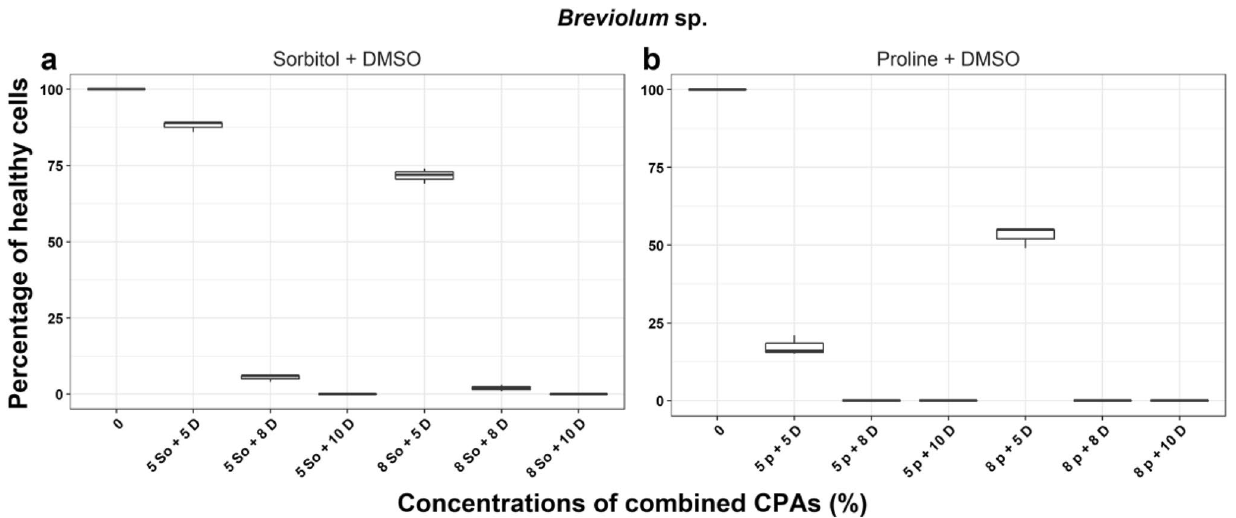
Figure 3. The percentage of healthy Breviolum sp. cells after treatment with combined cryoprotectant agents (CPAs) after one week incubation. D Dimethyl sulfoxide, So Sorbitol, p